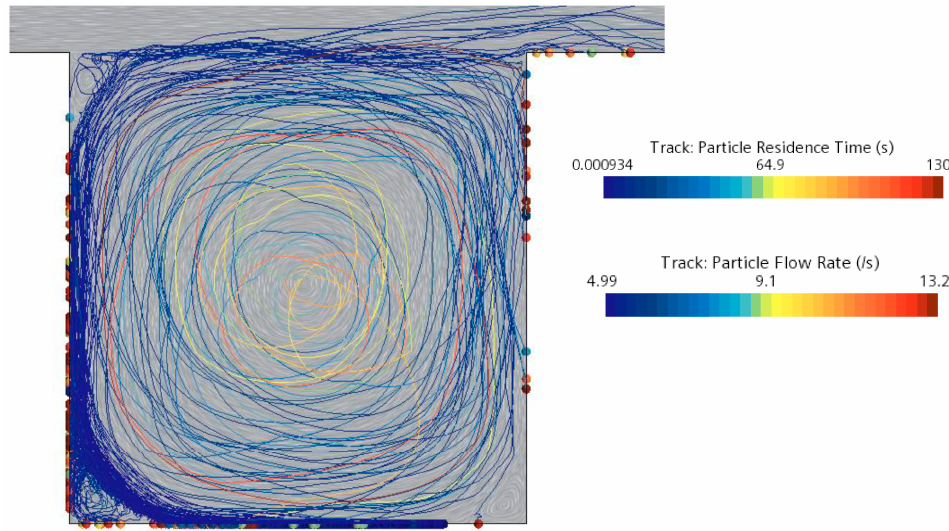
Figure 4. Particle dispersion and deposition inside the street canyon (H/W = 1, u ref = 12.5 m/s). The points on the street canyon surfaces represent the deposited parcels (particles) with a different mass (or number of particles). The lines represent particle tracks. On these lines, the particle residence time is displayed.